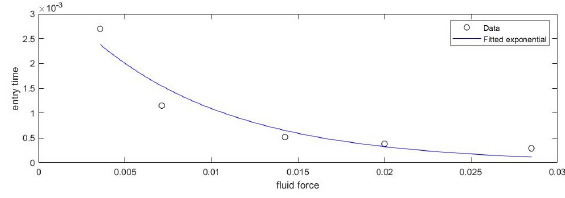
Fig. 3. Dependency of entry time on fluid force.